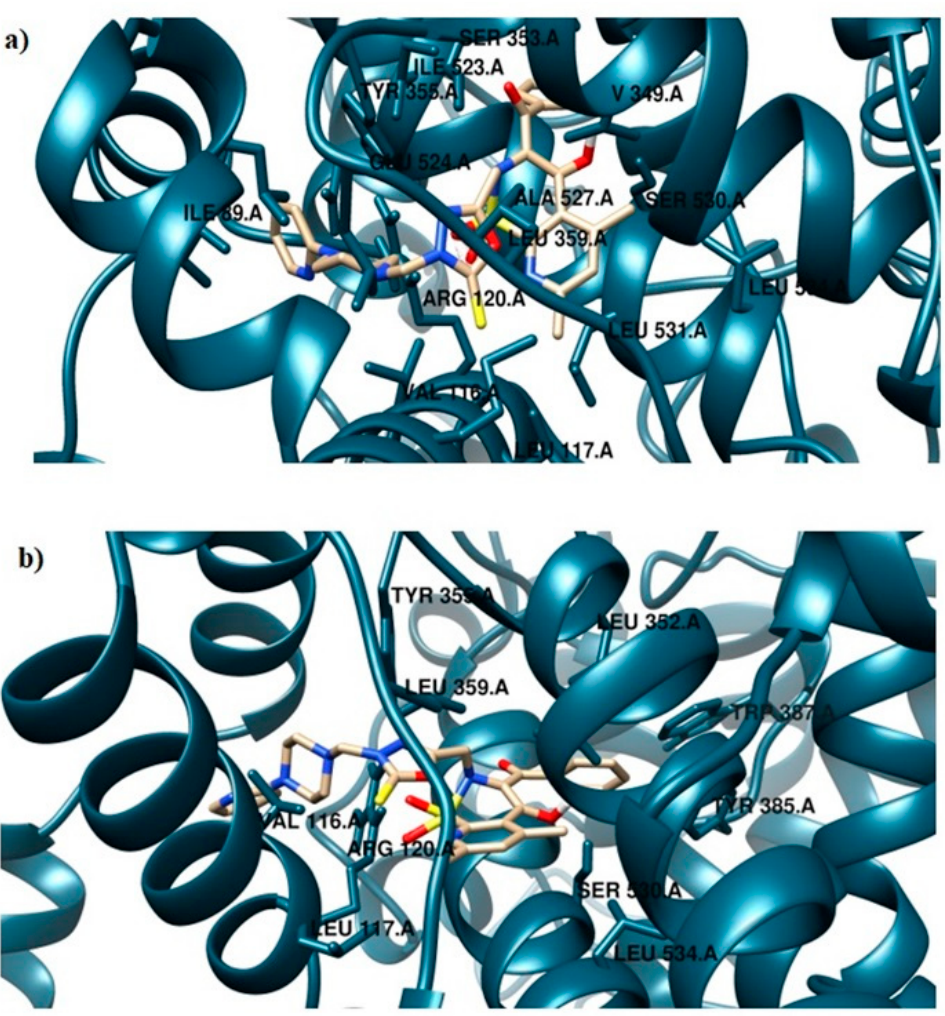
Figure 9. Binding mode of the analyzed compound: ( a ) TG11 –COX-1 complex and ( b ) TG11 – COX-2 complex.